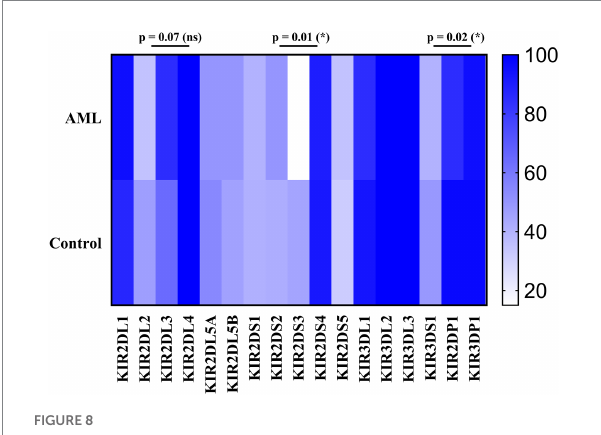
FIGURE 8 Heatmap of the individual KIR genes for the (top) AML and (bottom) Healthy Control groups. Color intensity ranges from white (mean < 20%) to dark blue (mean > 99%). Unpaired t-tests were used to compare the means of the analyzed genes between the 2 groups ( p < 0.05 (*); ns, not